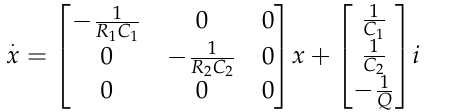
(cid:2) (cid:3) v 1 v 2 SOC , and Q represents the battery capacity. The v and v represent the voltages at the ends of 1 2